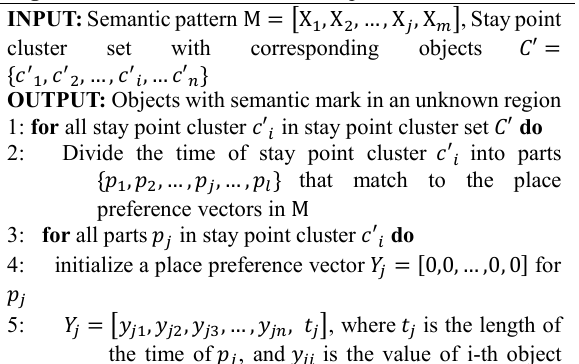
Algorithm 4 Automatic Semantic Map Generation